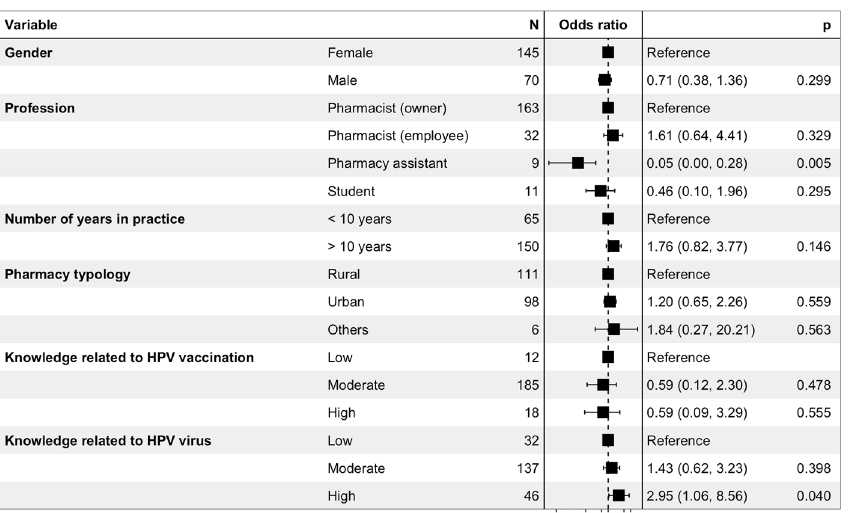
Figure 6. Binary logistic regression performed to evaluate the determinants of the right attitude toward HPV vaccination in general. The right attitude toward HPV vaccination in general corresponded to respondents that (i) were highly or very highly confident in HPV vaccines, (ii) felt comfortable or rather comfortable arguing with questions about vaccines in general, (iii) felt comfortable or rather comfortable arguing with questions about HPV vaccines, (iv) felt concerned about HPV, and (v) found that promoting HPV vaccination is part of pharmacists’ roles.